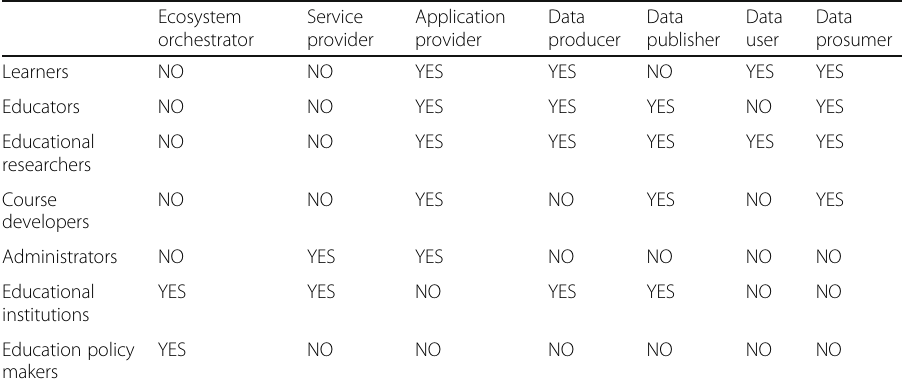
Table 4 Mapping current roles onto their roles in the BOLED analytics ecosystem Ecosystem